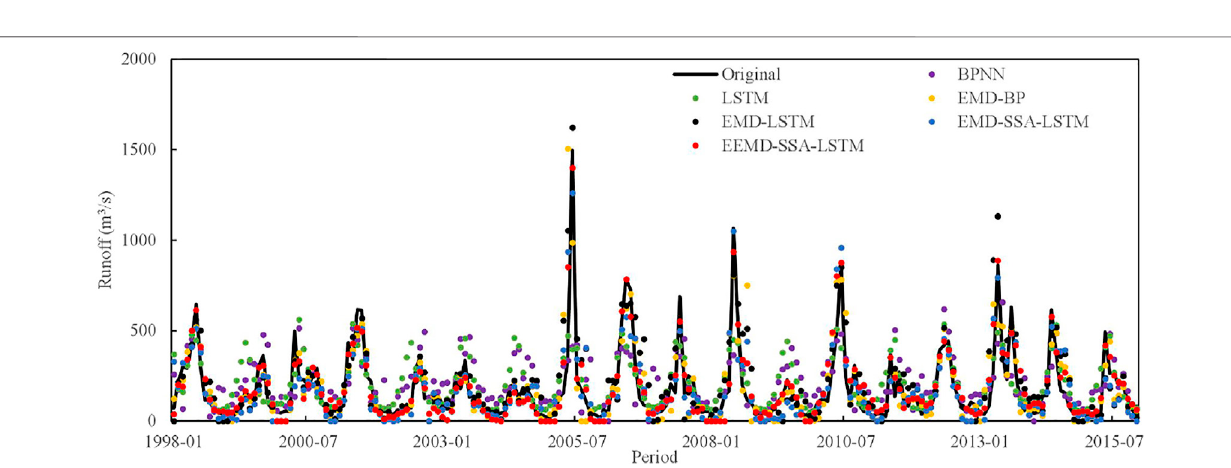
Frontiers in Environmental Science |